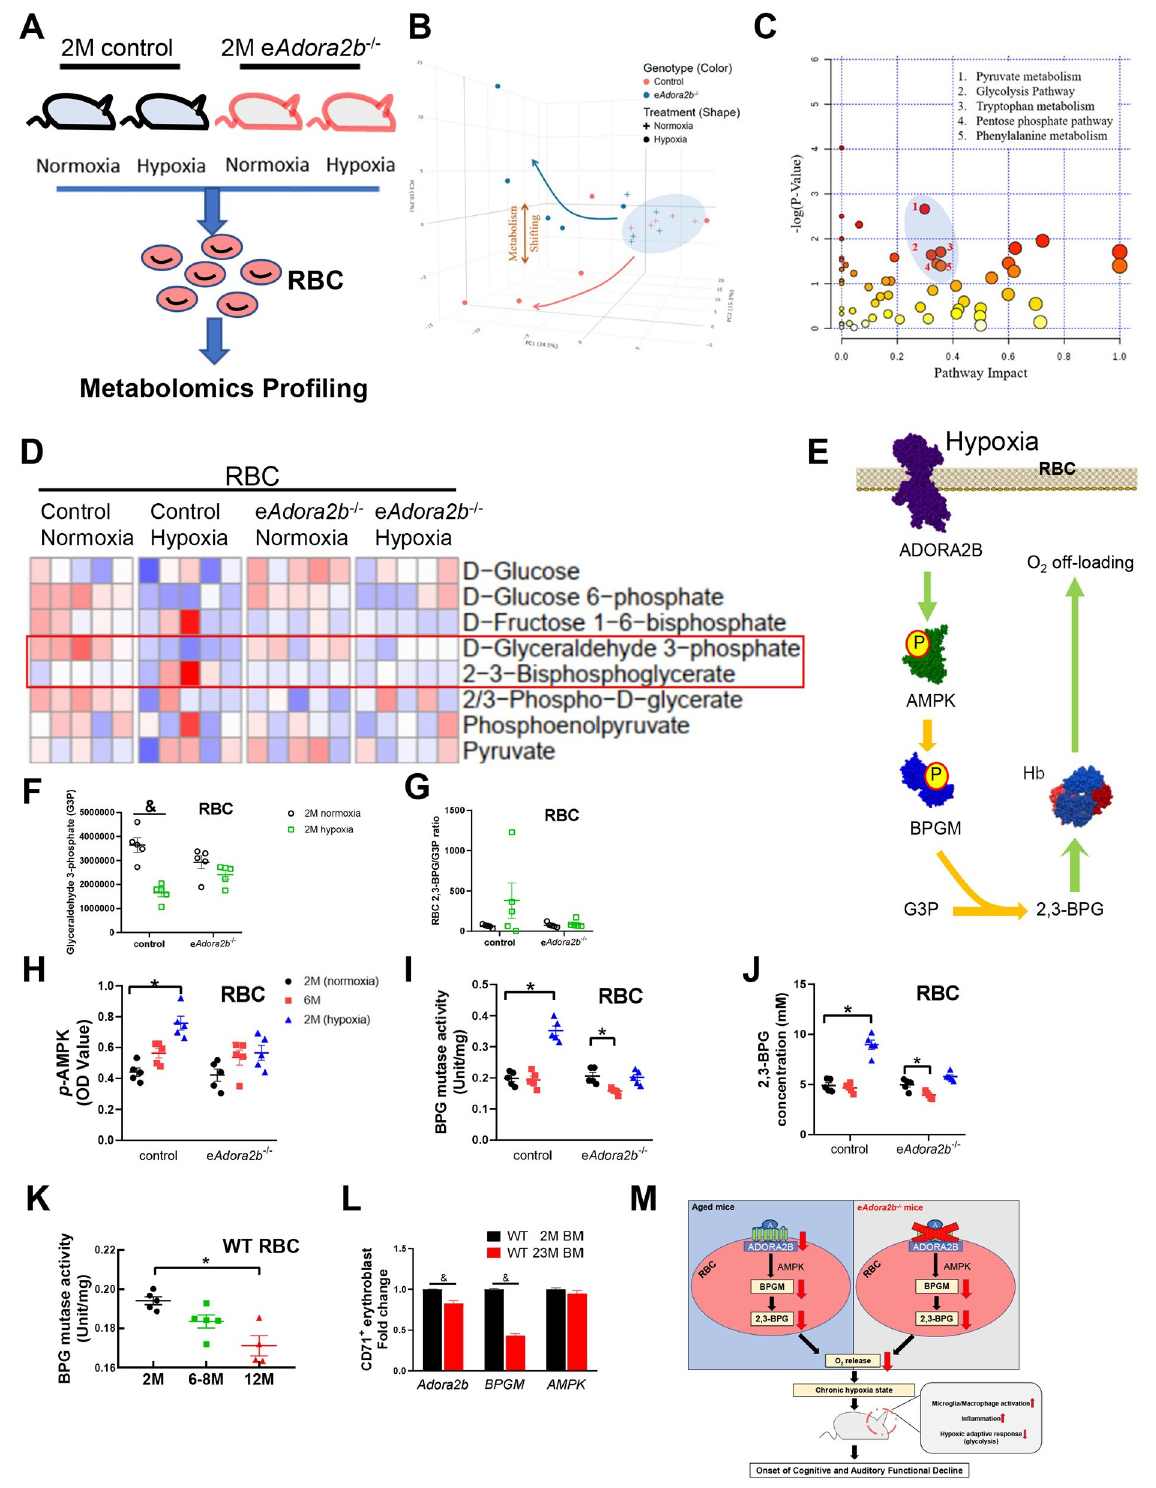
Fig 6. Hypoxia as the driving force resulted in reduced erythrocyte-mediated hypoxic metabolic reprogramming during aging. (A) Schematic representation of experimental design. Erythrocytes collected from 2-month-old controls and e Adora2b − / − mice with or without hypoxia treatment were evaluated by unsupervised metabolomics. n = 5 mice/group. (B) PCA revealed metabolic shift of e Adora2b − / − mice compared to control mice with or without hypoxia. (C) Metabolic pathway impact score of e Adora2b − / − - and control mice with or without